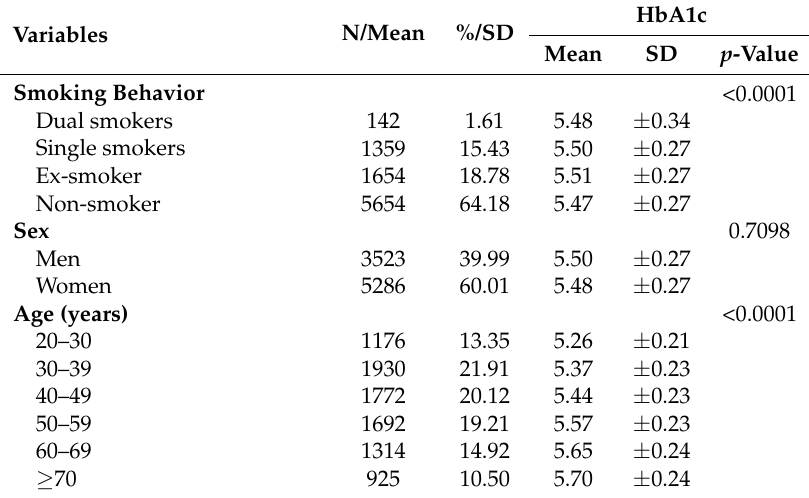
Table 1. The general characteristics of study